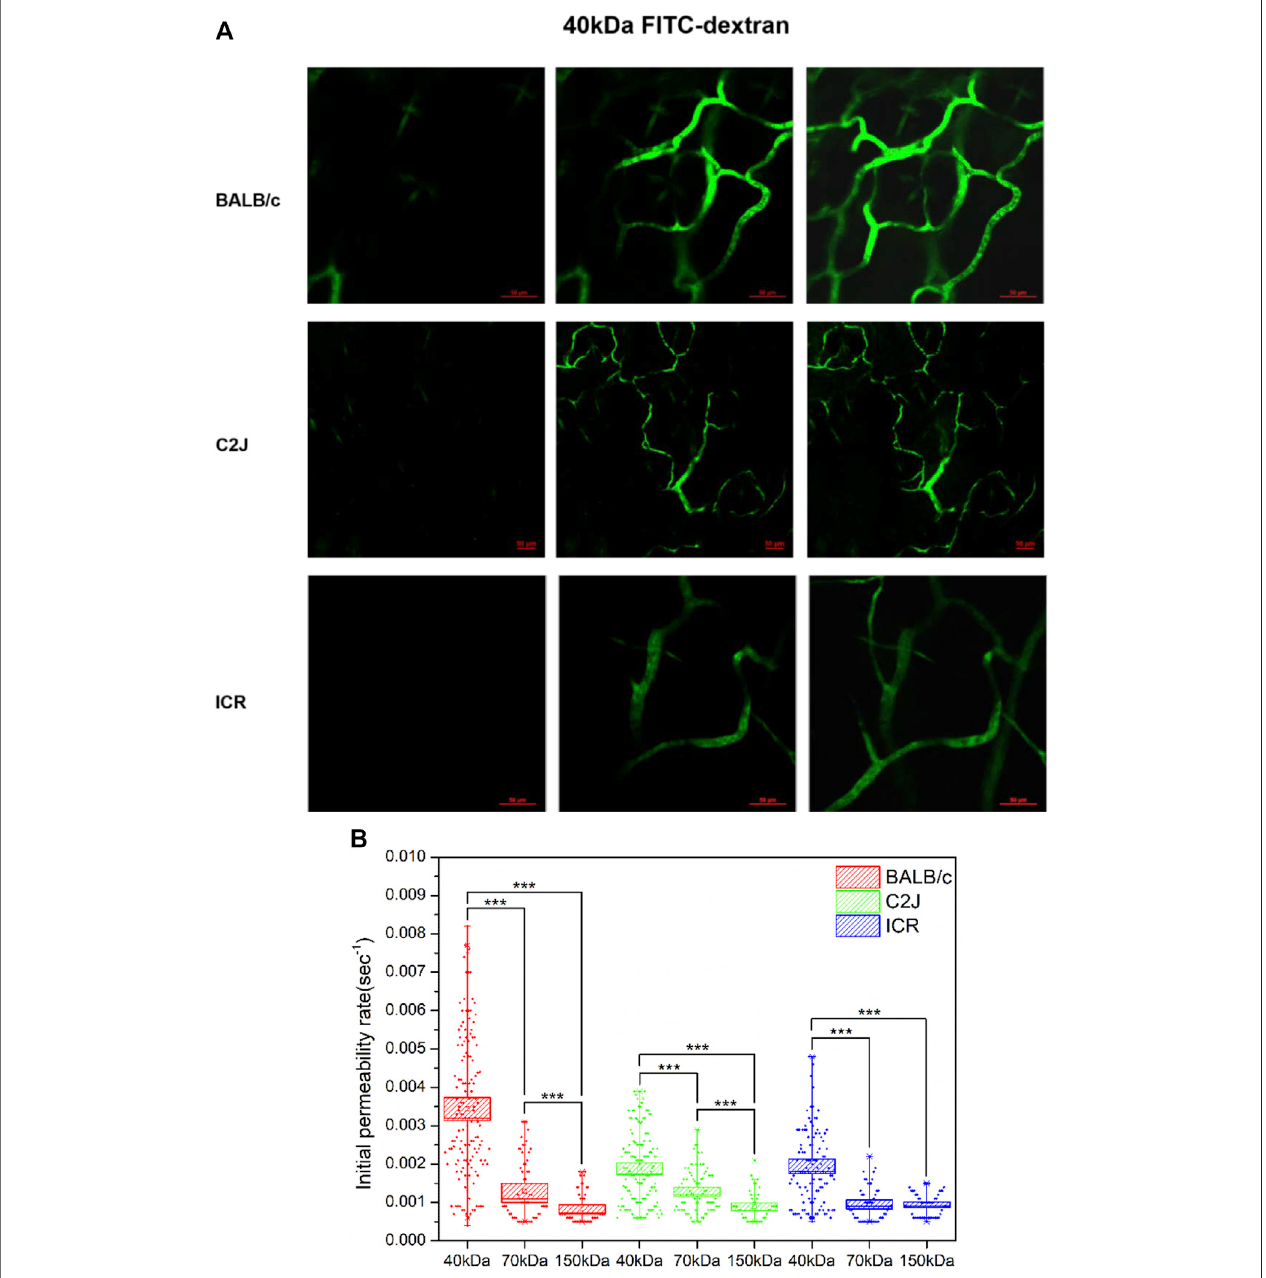
FIGURE2|(A) Representativeimagesoftwo-photon fl uorescenceangiographyof40 kDaFITC-dextraninjectedinthreestrainsofmice,respectively.Theseriesof images were taken at 15.4 – 20.7 s before injection (left column), right after dextran fl ush in (middle column) and at 57.2 – 86.6 s post injection (right column). Scale bars: 50 μ m. (B) TheinitialpermeabilityrateofFITC-dextranat40,70,and150 kDainthreemousestrainsofBALB/c,C2J,andICR,respectively.Thevalidmeasurementdata of each mouse within the same group were merged together to generate the box chart. The data are presented as mean ± SEM. Signi fi cant differences were analyzed using the one-way ANOVA with Tukey ’ s multiple comparison tests. *** p < 0.005.